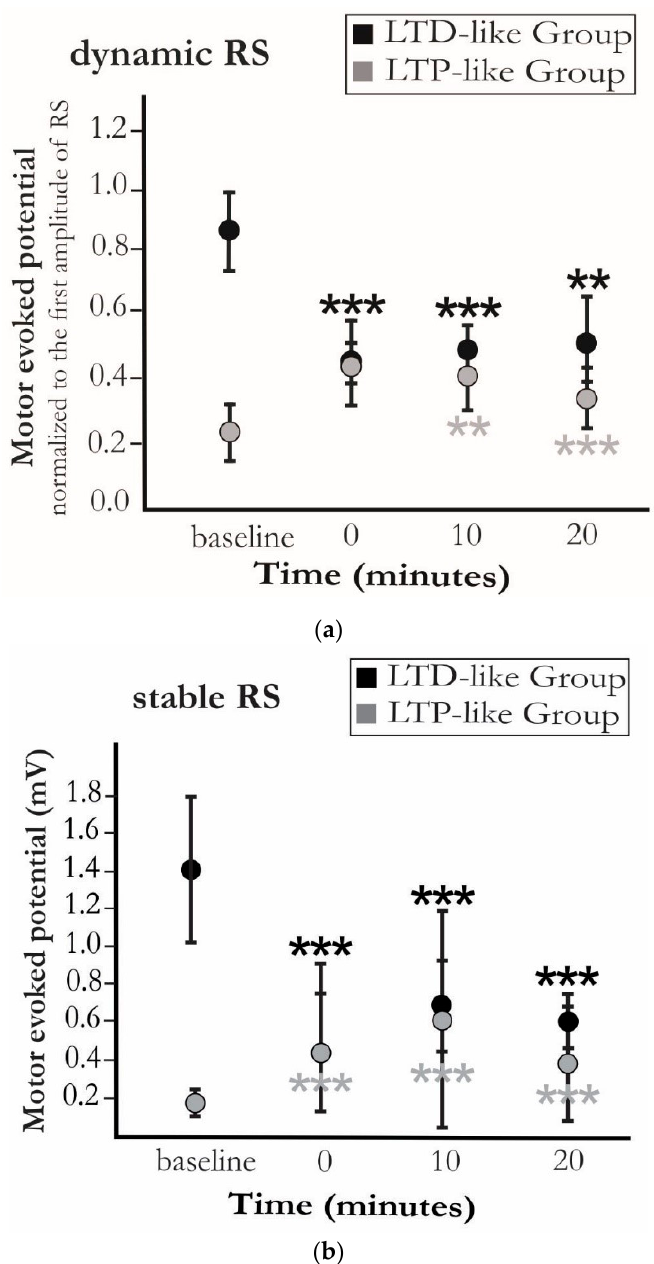
Figure 2. Changes in ( a ) dynamic component (mean ± standard error) and ( b ) stable component of RS (mean ± standard error), across the subjects from two clusters, within the trials before (baseline) and at 0, 10, and 20 min after the induction of short-term plasticity with PAS. Although dynamic RS was mild in the LTD-like group at baseline, a trend towards a stronger suppression and low variability at this level was observed in the LTD-like group following PAS. However, this trend in dynamic RS was towards recovery in the LTP-like group, as this component became milder with time. Similar trends, i.e., sustaining of the suppression and recovery from it, were also observed in stable RS after PAS in the LTD-like group and the LTP-like group, respectively. An asterisk indicates significant differences for pairwise comparisons between time points ( p < 0.01 for *** and p < 0.05 for **).